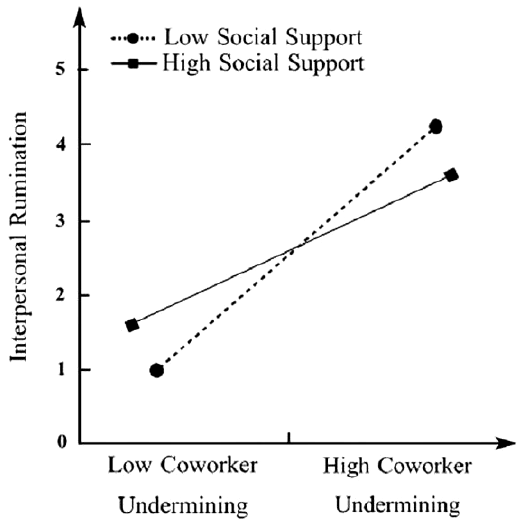
Figure 4. Interactive effect of unit co-worker social undermining and unit social support on interper- sonal